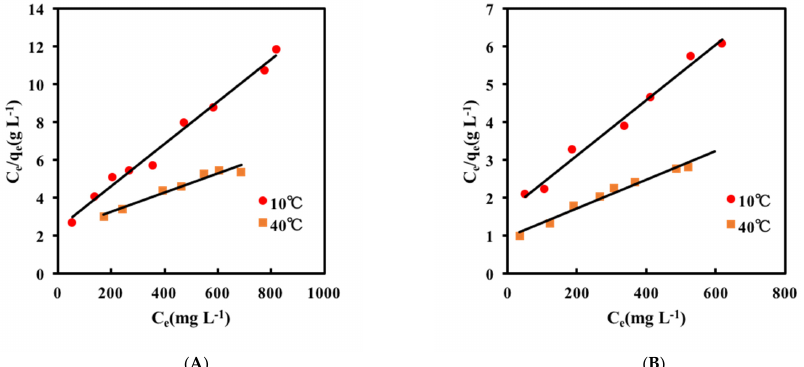
Figure 3. Isotherms of the As(III) adsorption in the ( A ) D-Mn and ( B ) D-Cr gels at different temperatures.